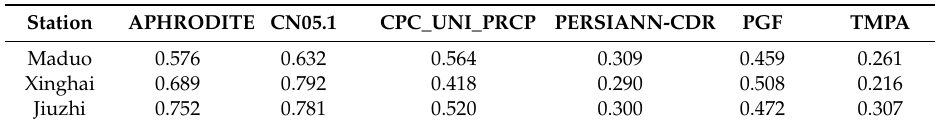
Table 5. Correlation coe ffi cients ( r ) between precipitation products and gauged-based observations at 3 meteorological station at daily